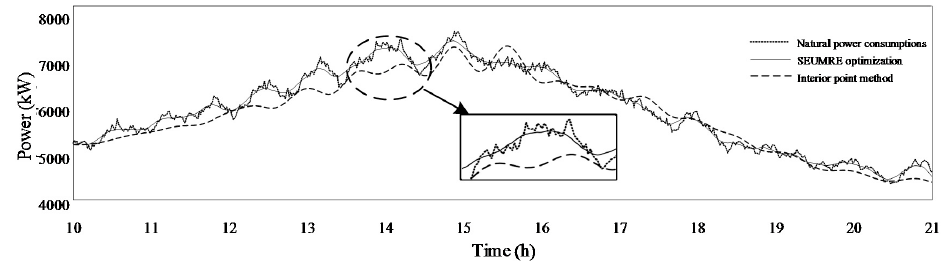
Figure 18. Optimization results of 60 CAC.